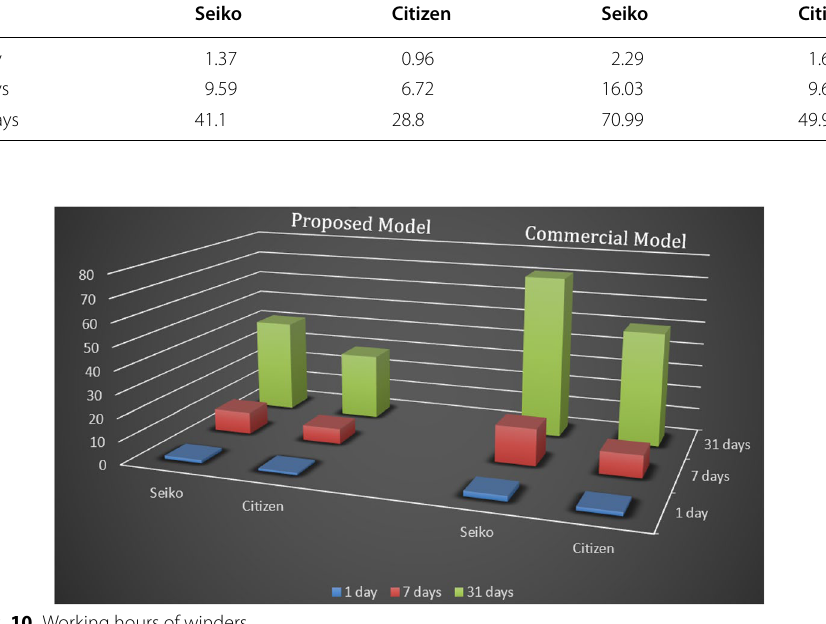
Table 5 Comparison of working hours of the proposed and commercial winders Total working